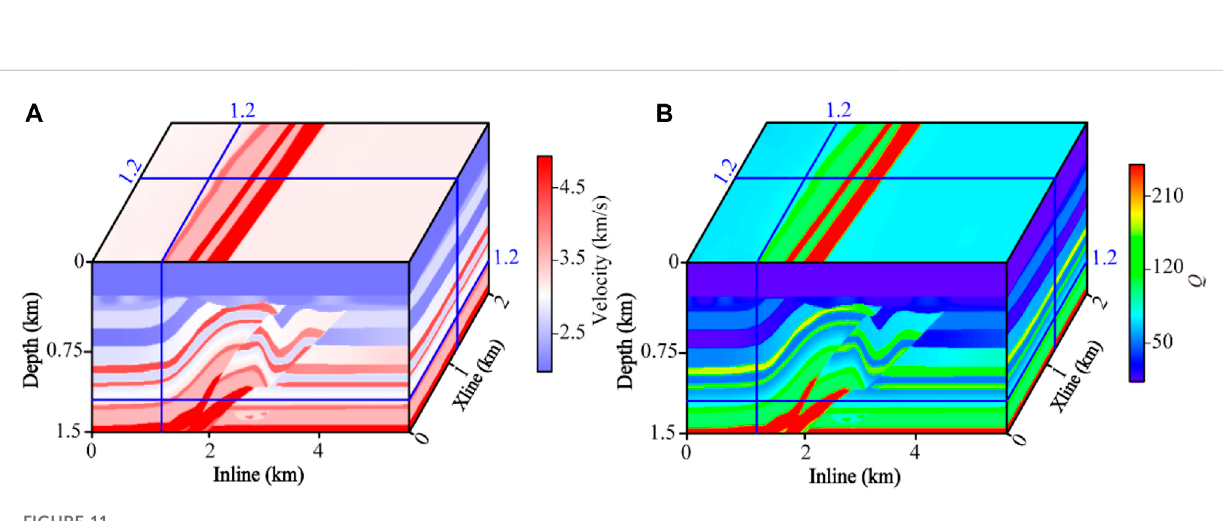
FIGURE 11 3D overthrust model. (A) Velocity; (B) Q